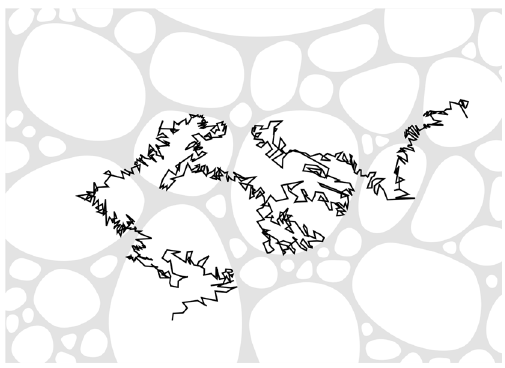
Figure 1. A schematic representation of the diffusion in a two dimensional compartmentalized medium. A particle (black trajectory) diffuses freely inside the domains (white areas) but only rarely crosses the thick divisions between them (grey area) which are thin compared to the average size of the domains and act as